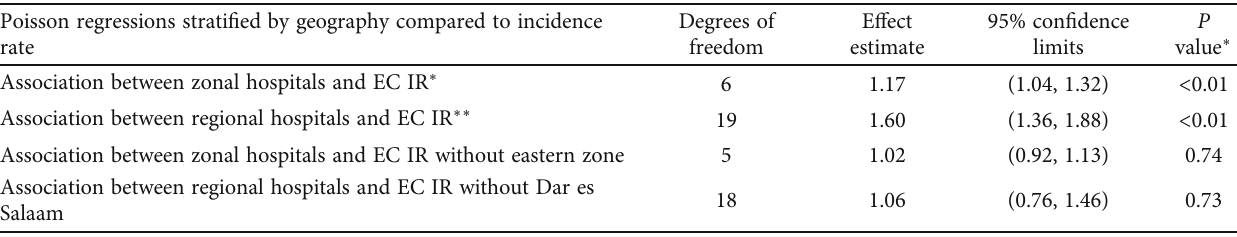
Degrees of E ff ect